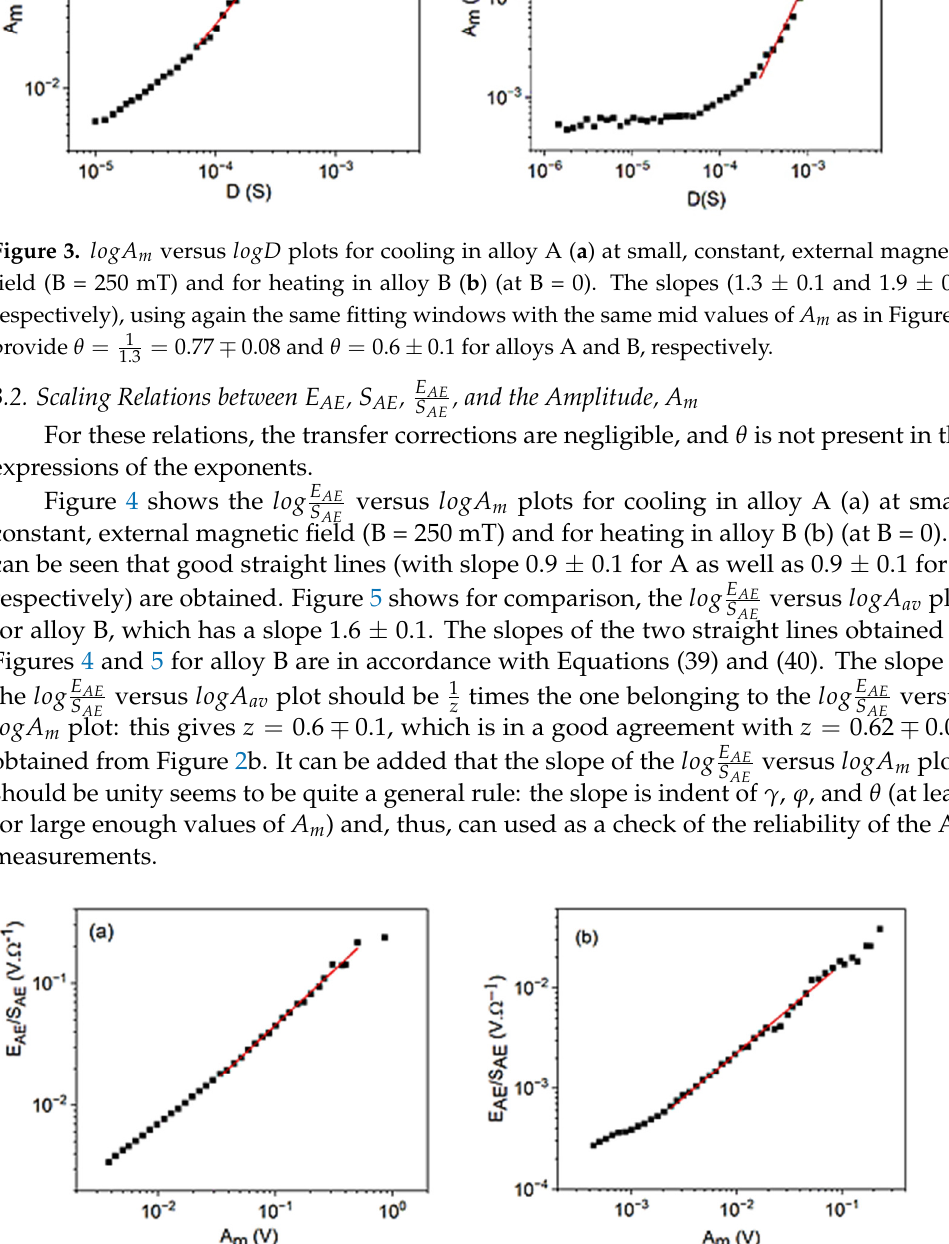
Figure 5.      versus   plot for heating in alloy B (at B = 0). Figure 6 shows the   versus   plots for cooling in alloy A (a) at small, con- stant, external magnetic field (B = 250 mT) and for heating in alloy B (b) (at B = 0). In the intermediate regions, a straight line can be fitted. The slopes are 1.2 ∓ 0.1 and 1.11 ∓ 0.05 , respectively, and from Equation (32)  = 0.8 ∓ 0.1 as well as  = 0.90 ∓ 0.08 are ob- tained. Figure 6.   versus   plots for cooling in alloy A ( a ) at small, constant, external magnetic field (B = 250 mT) and for heating in alloy B ( b ) (at B = 0).